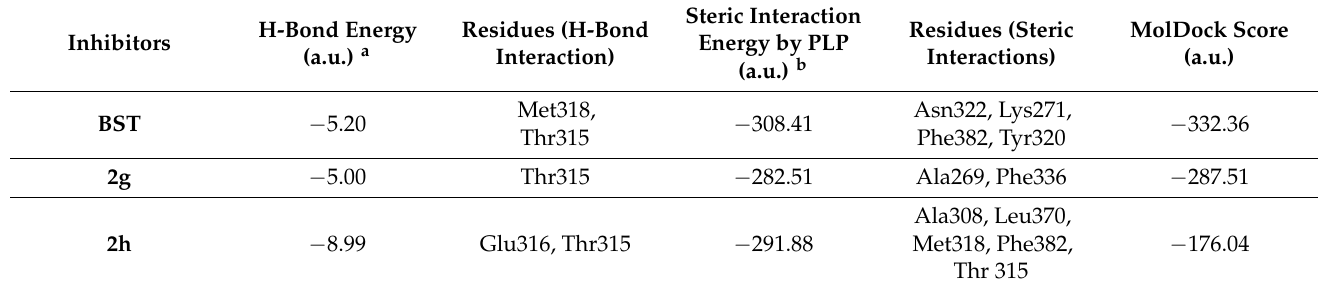
Figure 7. Overlays of the predicted poses of the BCR-ABL1 inhibitors: ( a ) IMT (yellow) and 2g (blue) and ( b ) IMT (yellow) and 2h (pink). The inhibitor structures are shown as stick representations. Table 3. Summary of the interactions between inhibitors BST, 2g , and 2h and the tyrosine kinase BCR-ABL1